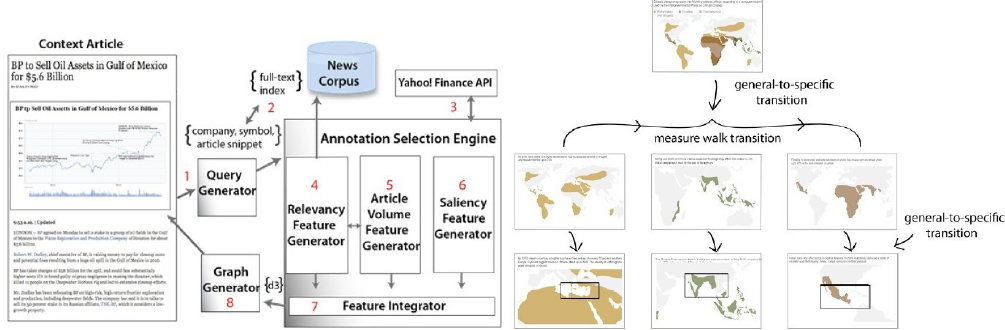
Figure 13. Hullman et al. show the architecture of contextifier [32] ( left ) and illustrate Parallelism in sequencing in the NYT Copenhagen [14] ( right ). Image courtesy of Hullman et al.